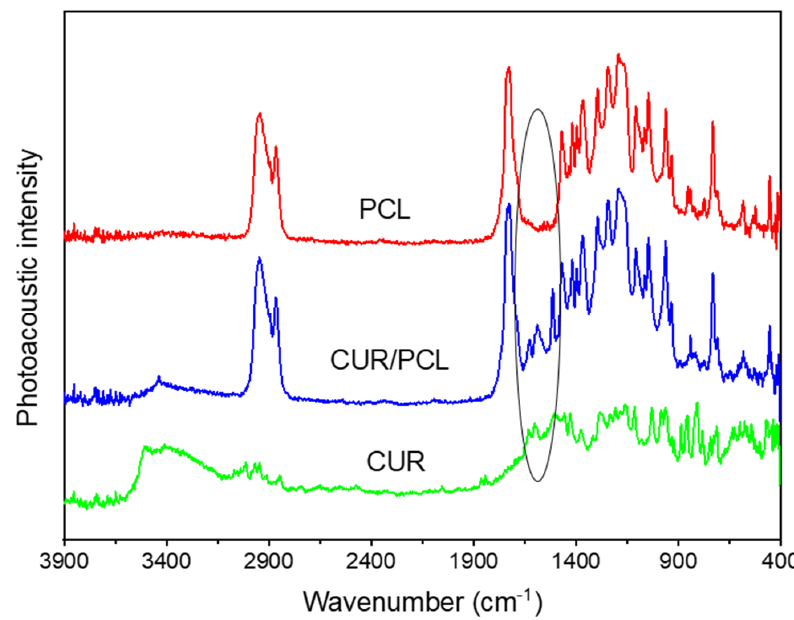
Figure 5. Photoacoustic Fourier-transform infrared (PA-FTIR) spectra of pure curcumin (CUR), blank PCL scaffold, and curcumin-loaded PCL scaffold (7%, w / w ).